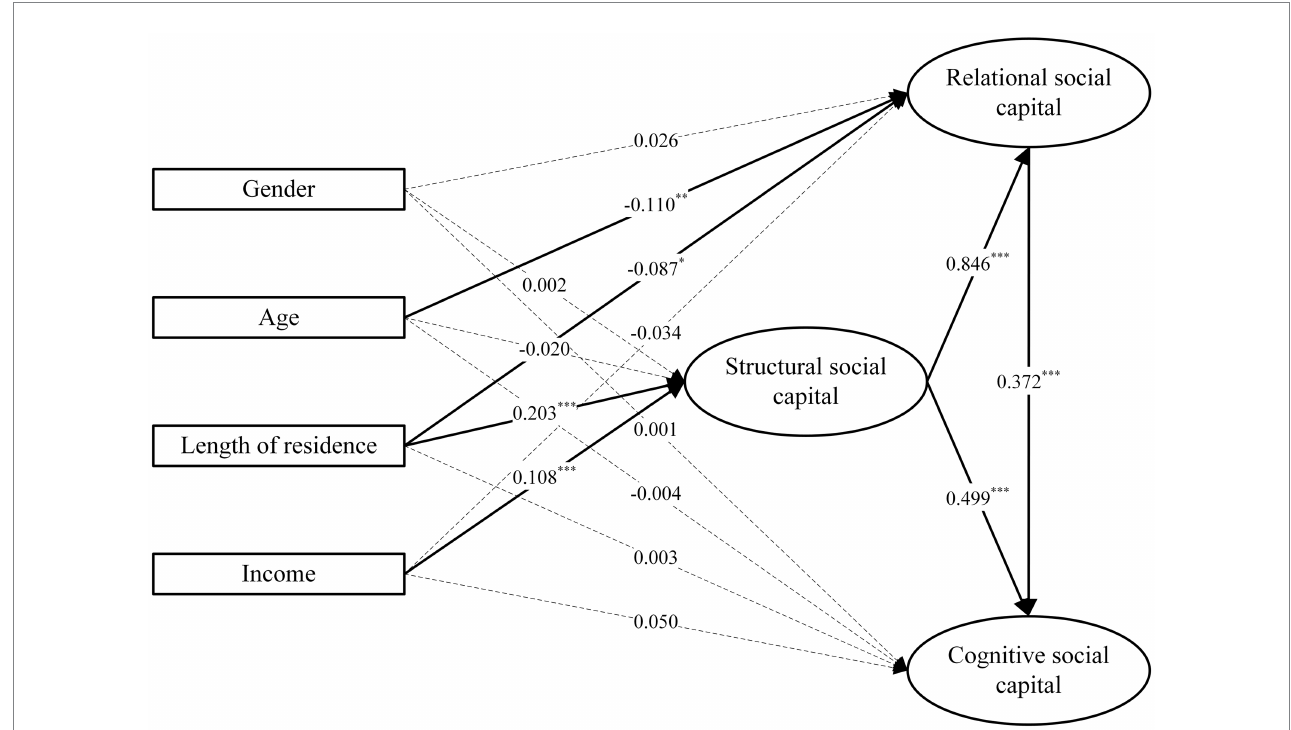
FIGURE 2 MIMIC model with the effects of the covariates on the latent theoretical constructs. * p < 0.05, ** p < 0.01, *** p < 0.001; dashed lines =